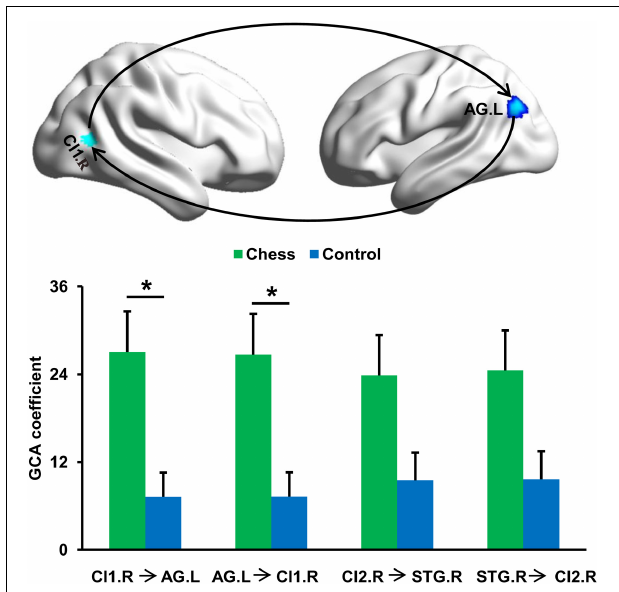
FIGURE 3 | Changes in effective connectivities. Chess experts showed increased mutual effective connectivity between Cl1.R and AG.L compared with novice players. No significant difference in effective connectivity between Cl2.R and STG.R in chess experts was found compared with novice players. ‘*’ represents the significant